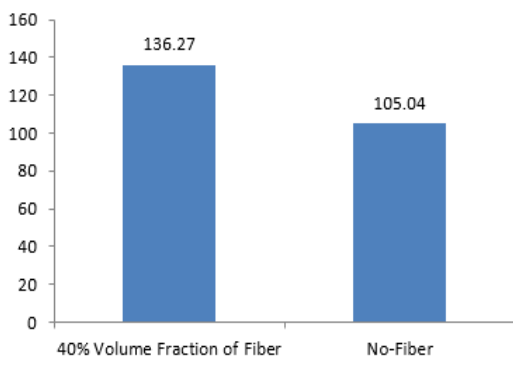
Figure 8: The Variation of flexural strength of specimens with different factors produce with different